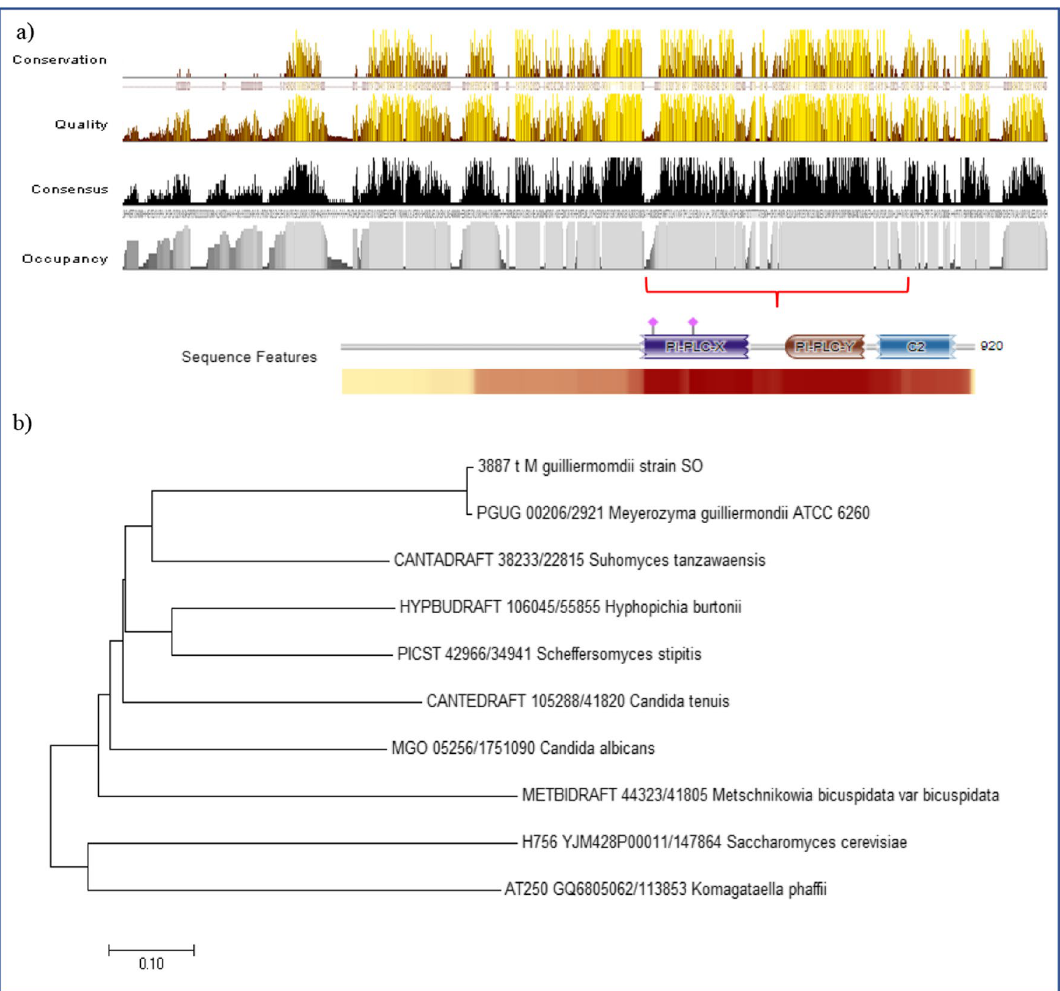
Fig. 3 Profiling of putative phospholipase C encoding gene according to public databases to signify virulence factors as indicated pathogenic in C. albicans . a The consensus region of phospholipase C from HMM hits coordinate represented using BioEdit and b the phylogenetic tree of M. guilliermondii strain SO from HMM phospholipase C